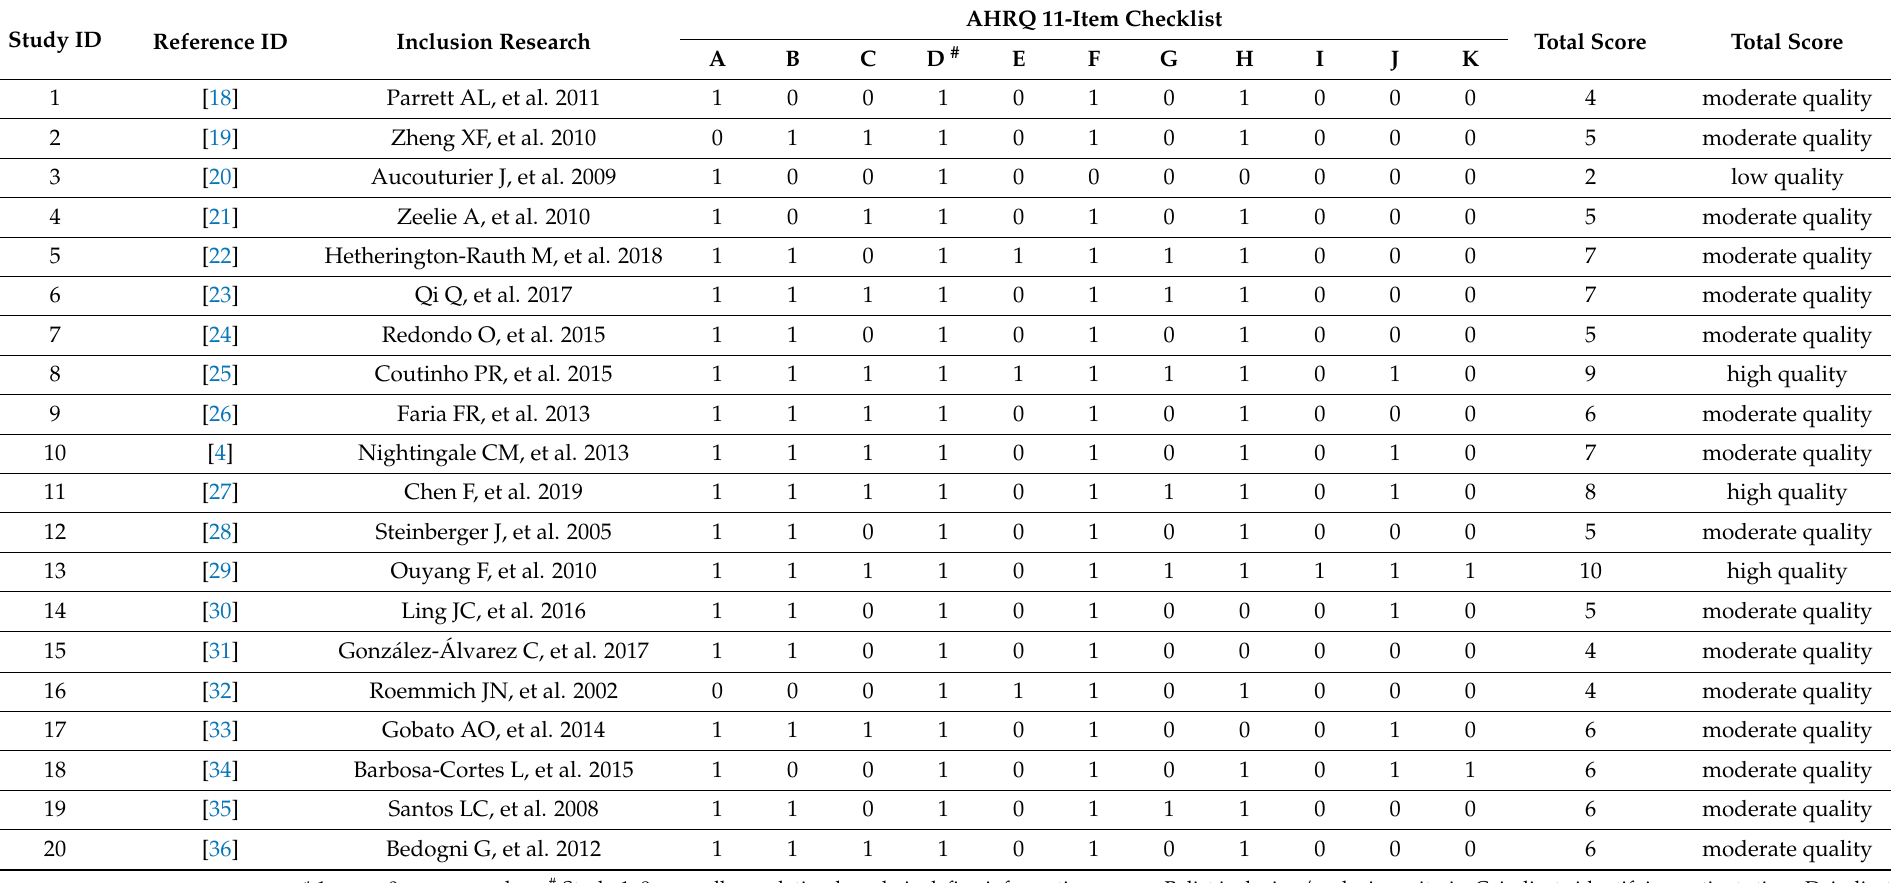
Table 2. The quality evaluation of the methodology according to Agency for Healthcare Research and Quality (AHRQ, US 2004) assessment forms